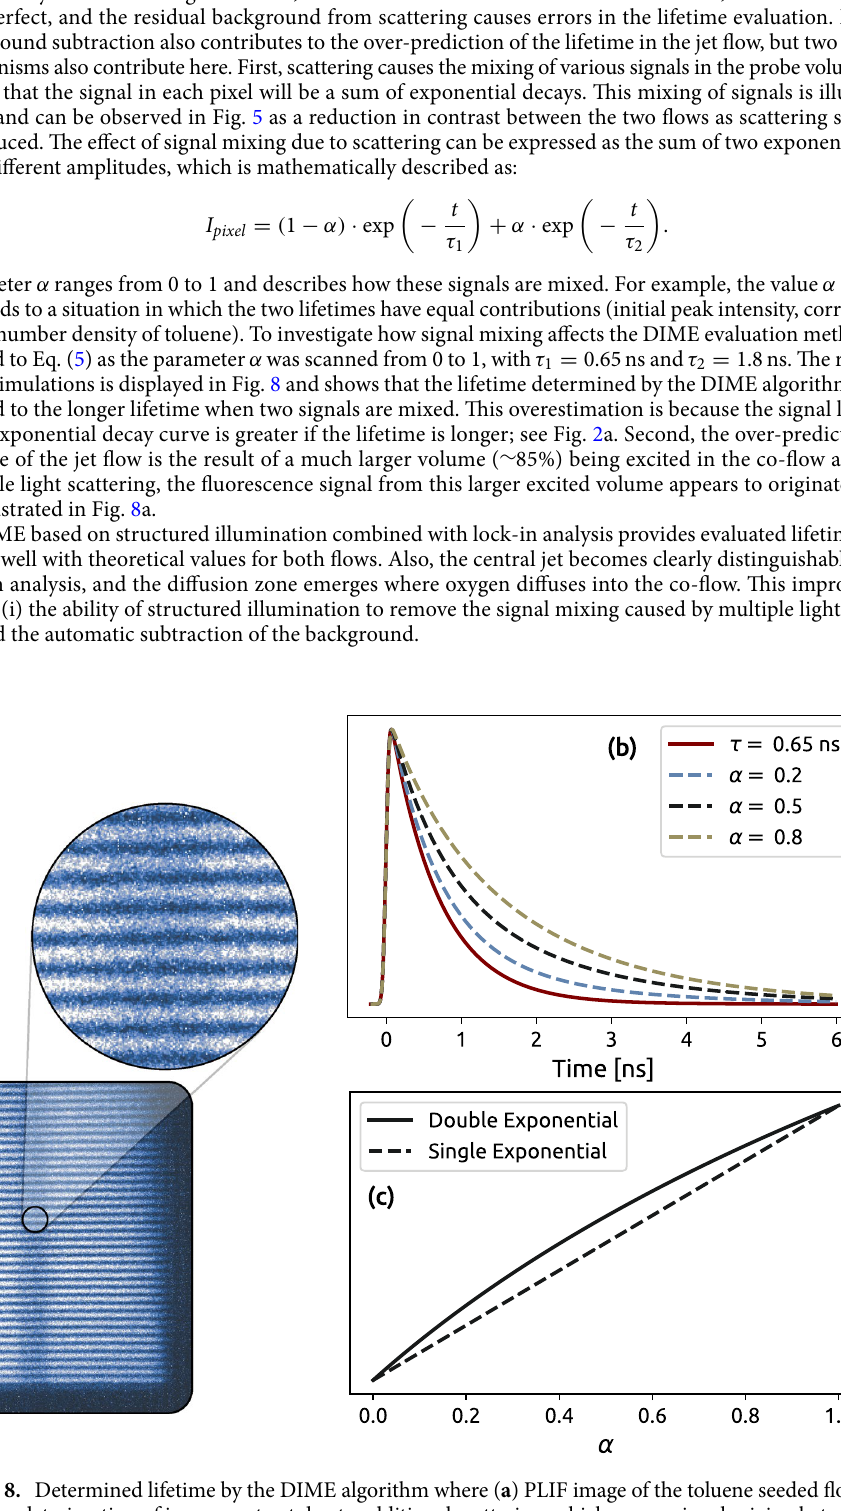
Figure 8. Determined lifetime by the DIME algorithm where ( a ) PLIF image of the toluene seeded flows display a deterioration of image contrast due to additional scattering, which causes signal mixing between jet- and co-flow. ( b ) Decay curves from mixed dual exponential decays show an increase in lifetime with higher mixing. ( c ) Dual exponential (dashed line) and a single exponential decay (solid line) with a mixing value of ( α ) τ ( 1 α) τ 1 α τ 2 = − · + ·